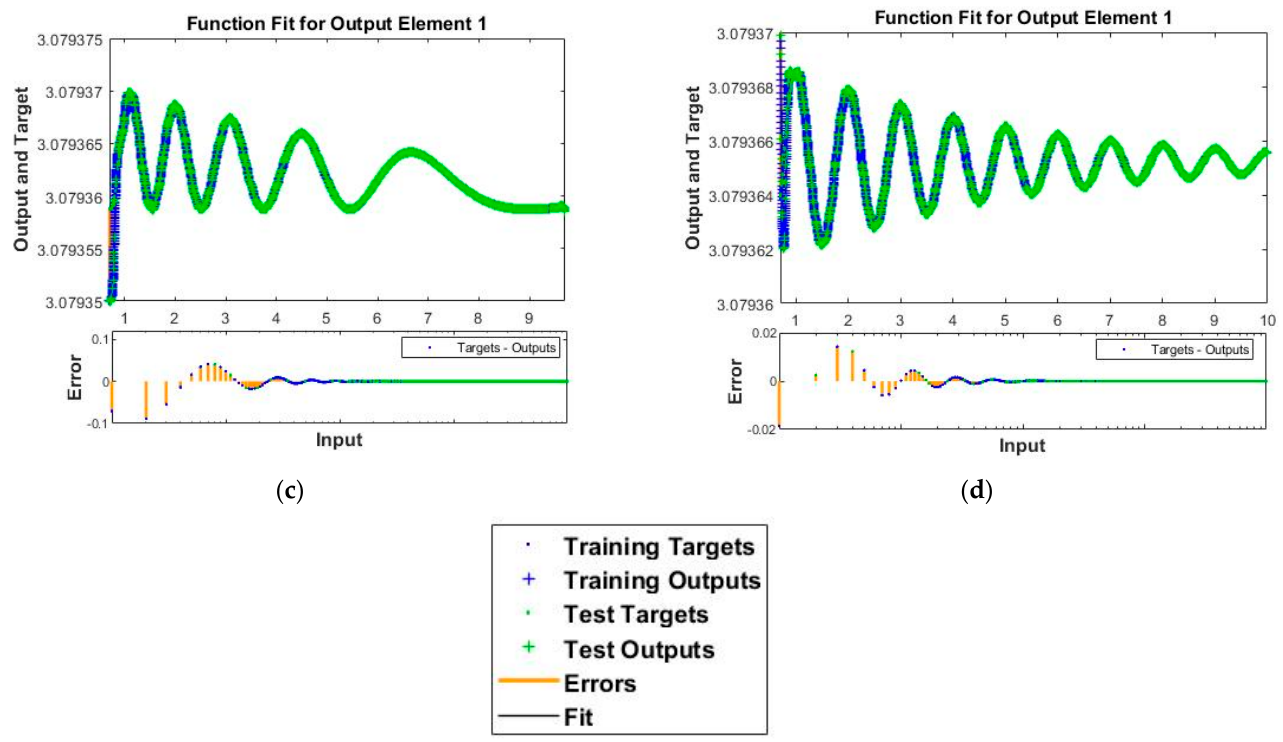
Figure 8. Function fitness curves for target, output elements, and error of all four cases of BRM ‐ NNs piezoelectric actuator. ( a ) BRM ‐ NNs Case 1. ( b ) BRM ‐ NNs Case 2. ( c ) BRM ‐ NNs Case 3. ( d ) BRM ‐ NNs Case 4.